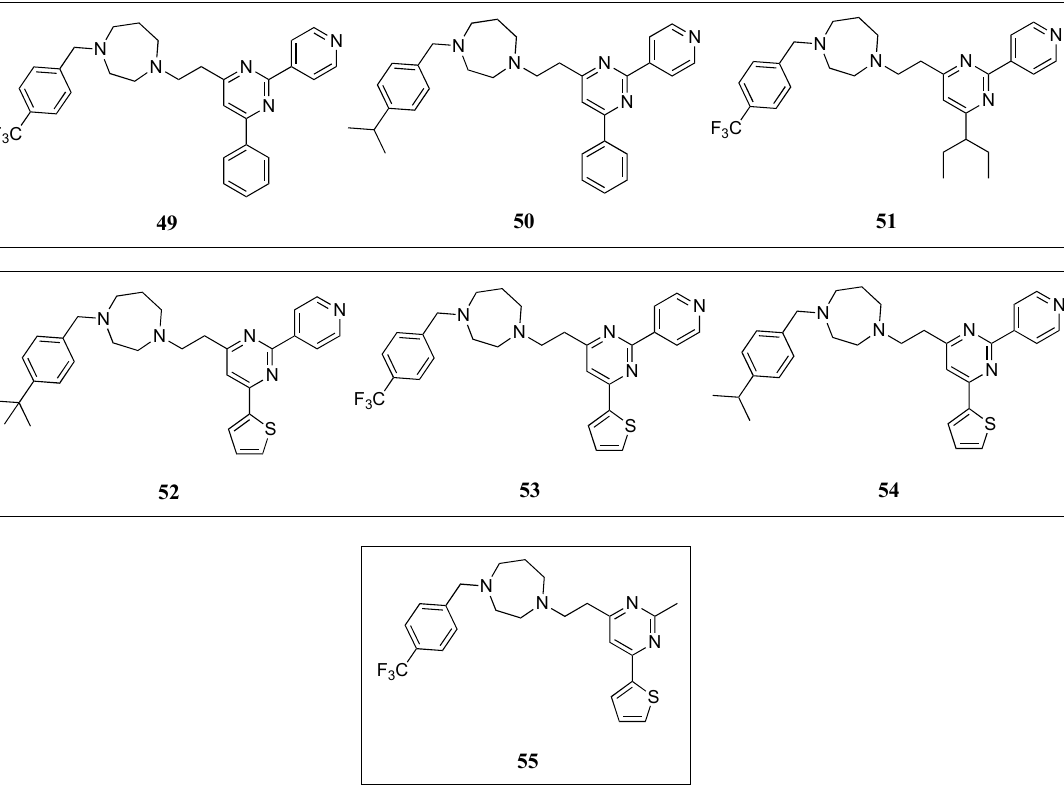
Figure 10. Chemical structures of the pyrimidine derivatives. Table 9. MIC values of the pyrimidine analogues on drug-sensitive strains.